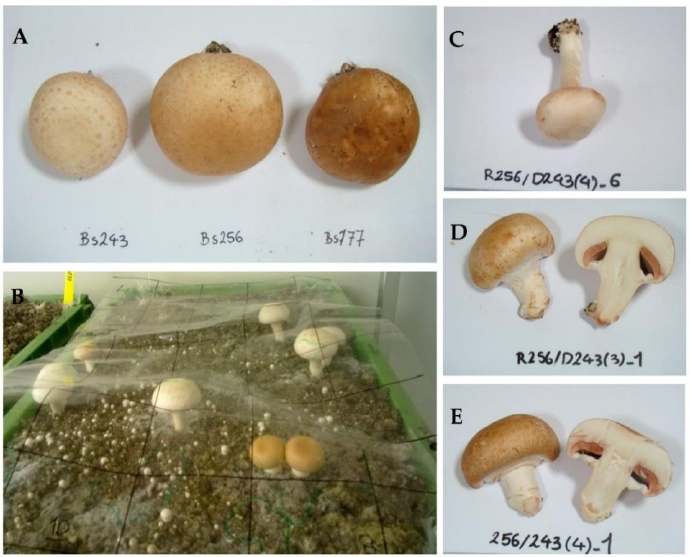
Figure 2. Basidiomata of parental strains ( A ) or growing on a culture tray of Bs256 having received propagules from Bs243 ( B – E ). ( A ) Basidiomata of Bs243, Bs256, and Bs177 have cream, medium brown and brown caps, respectively; ( B ) basidiomata of different phenotypes and development stages growing on a culture tray — in order to